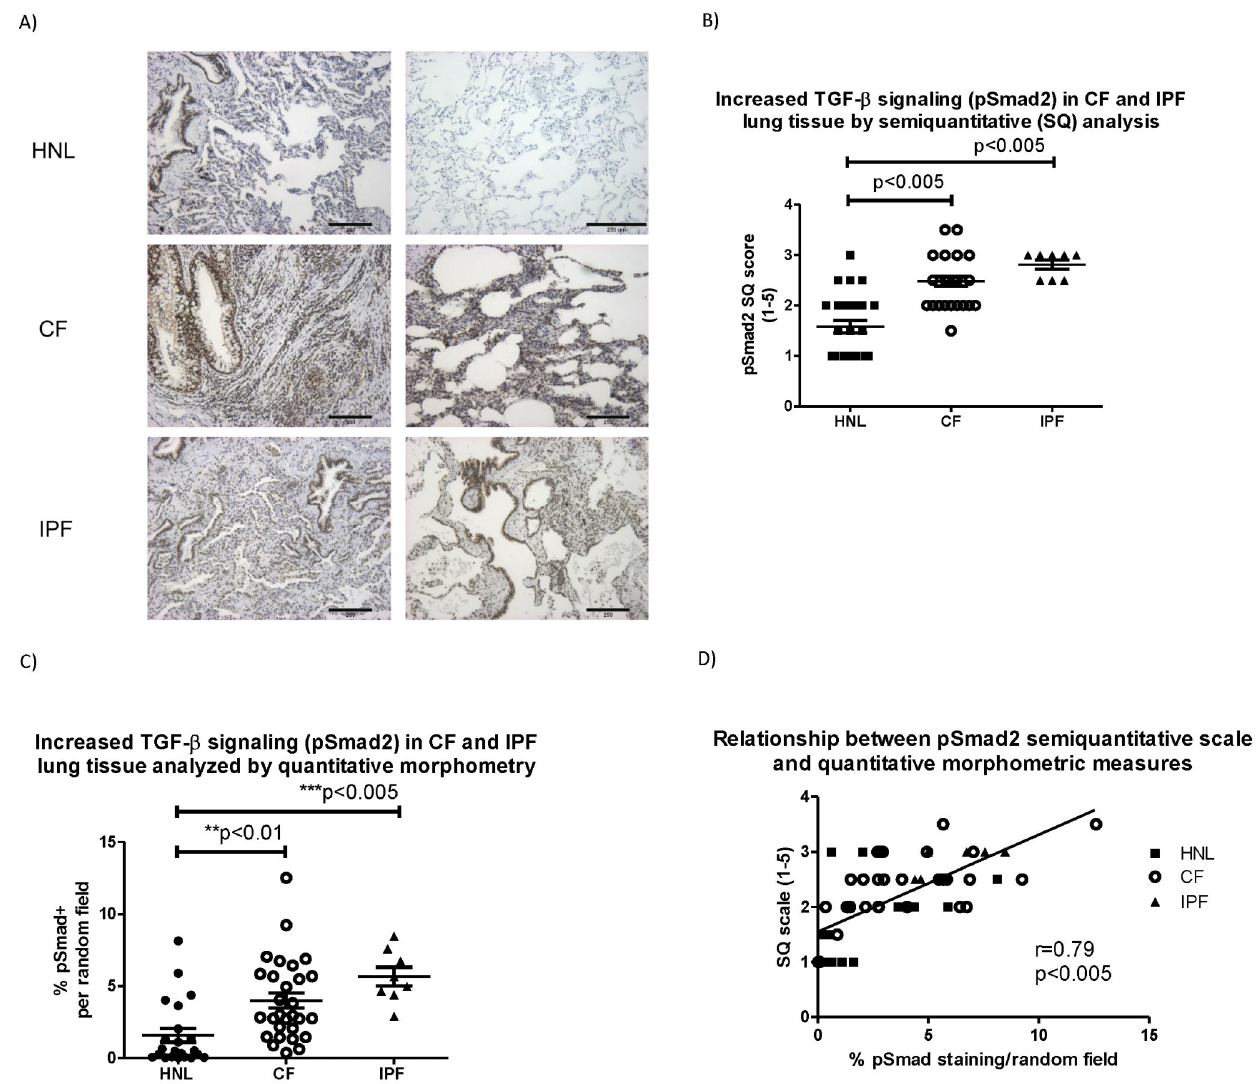
Figure 1. Increased TGF- b signaling in lung tissue from cystic fibrosis (CF) and idiopathic pulmonary fibrosis (IPF) compared to non- CF human normal lung tissue (HNL). A) Immunohistochemical staining for phosphorylated Smad2 (pSmad2 shown in brown). The downstream signal of TGF- b is significantly increased in CF compared to HNL tissue and comparable to that seen in IPF. Images are shown at approximately 100 6 from 2 separate CF, HNL and IPF specimens (bar=250 m m). B) Comparison of TGF- b signaling (pSmad2 staining) by semiquantitative score (1–5). C) Comparison of TGF- b signaling (pSmad2 expression) by quantitative morphometry. D) Correlation between semiquantitative scale (1–5 scale) and morphometric measures of pSmad2. doi:10.1371/journal.pone.0070196.g001 11.2 6 1.6%, p , 0.01) (Figure 2C). Tissue morphometry and significant correlation between the semiquantitative and quantita- semi-quantitative analysis were again well-correlated (r =0.68, tive measures (r =0.79, p , 0.005) (Figure 1D). p , 0.005) (Figure 2D). Myofibroblast differentiation in human CF lung tissue Myofibroblasts were increased in human CF lung tissue compared to HNL, as determined by IHC for a -SMA (Figure 3). In blinded semiquantitative analysis, CF lung tissue demonstrated myofibroblast prominence (CF: 2.8 6 0.2, HNL 1.4 6 0.1, p , 0.005) (Figure 3B). Quantitative analysis indicated myofibroblasts occu- pied a higher percentage of each random field (100 6 ) in CF vs. (Figure 2B). Quantitative analysis by tissue morphometry led to non-diseased individuals (CF: 9.8 6 1.0%; HNL 2.5 6 0.4%, the same conclusion, with a greater percentage of fibrosis present p , 0.005) (Figure 3C). Morphometry correlated with semi- in each random field at 100 6 (CF: 21.8 6 1.8%, HNL: quantitative analyses (r =0.72, p , 0.005) (Figure 3D). The